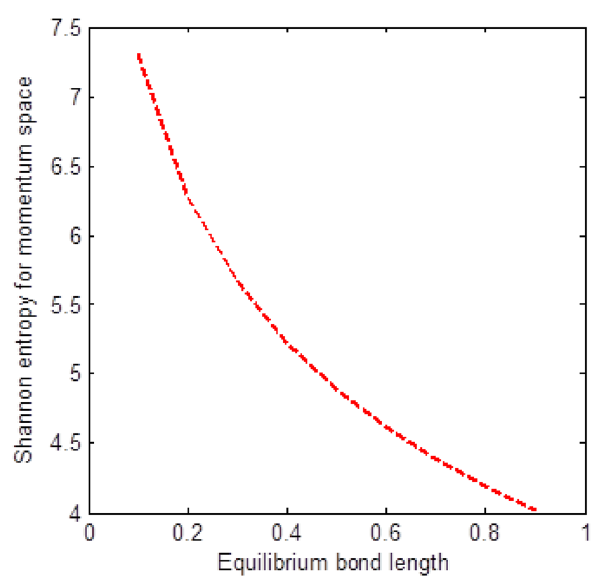
Figure 5. Shannon entropy for momentum space against the equilibrium bond length with µ = n = ℓ = (cid:31) = D e = (cid:31) = 1, and C = 0 of the pseudoharmonic-like potential